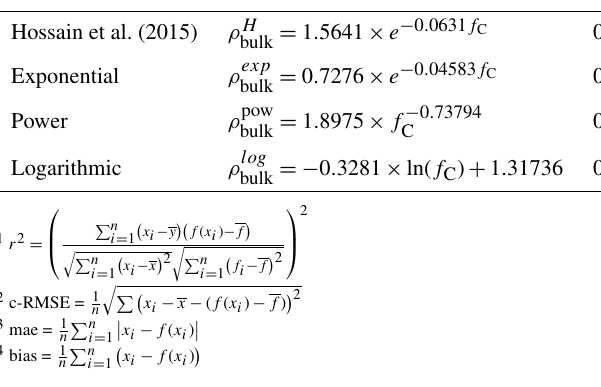
Table 5. Statistical scores for different regressions between bulk density ρ bulk and carbon content f C . Regression